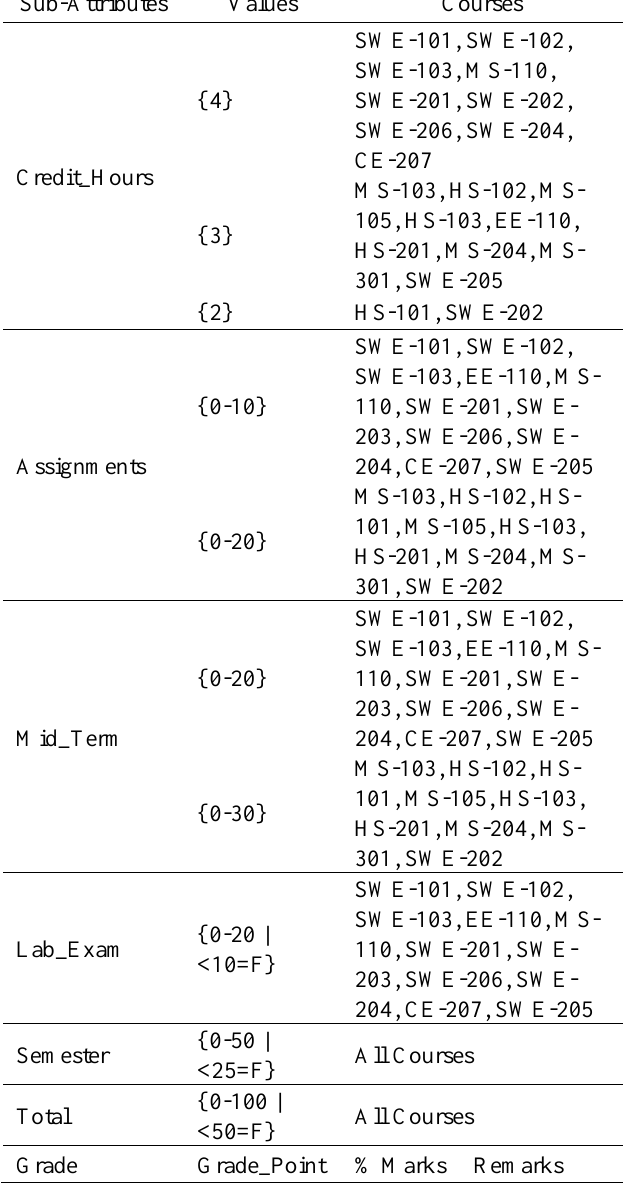
List of Sub-Attributes of each